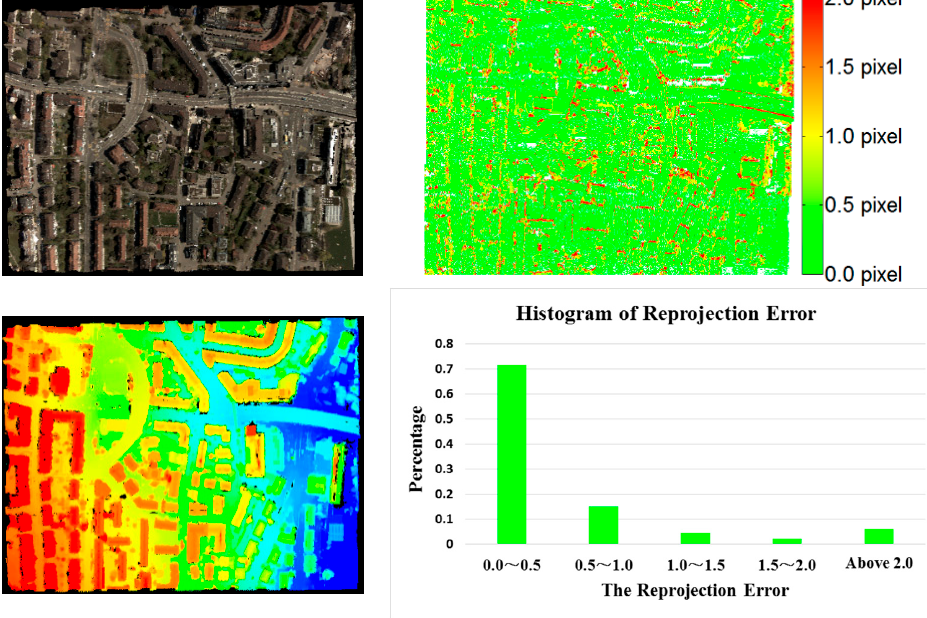
Figure 8. The dense matching results of image-954. (Top left: the colorized point cloud, Bottom left: the height map of the point cloud, Top right: the accuracy map rendered by average reprojection error, Bottom right: the histogram for the reprojection error).